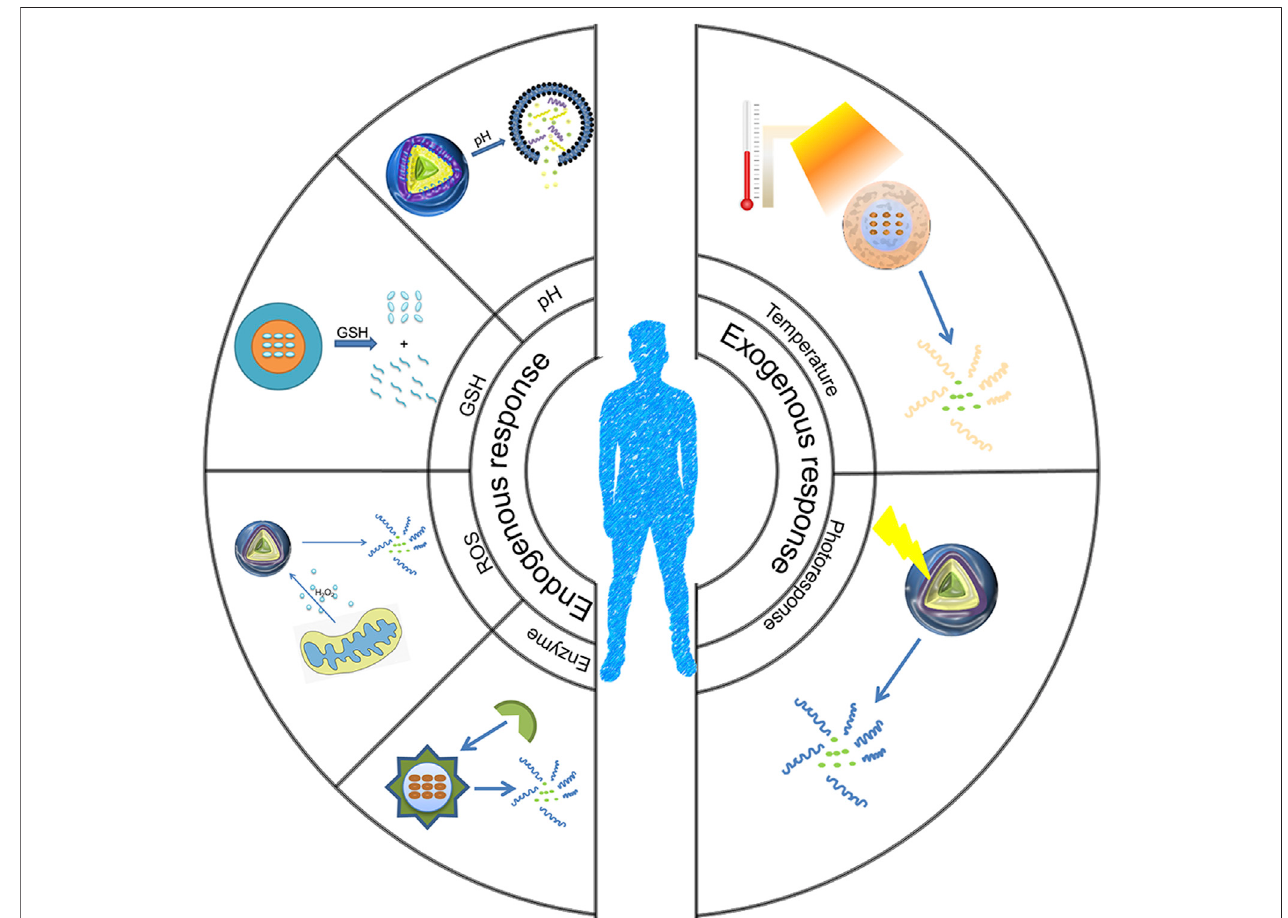
FIGURE 1 | Schematic diagram of the environmentally responsive nanogels responding to environmental changes.